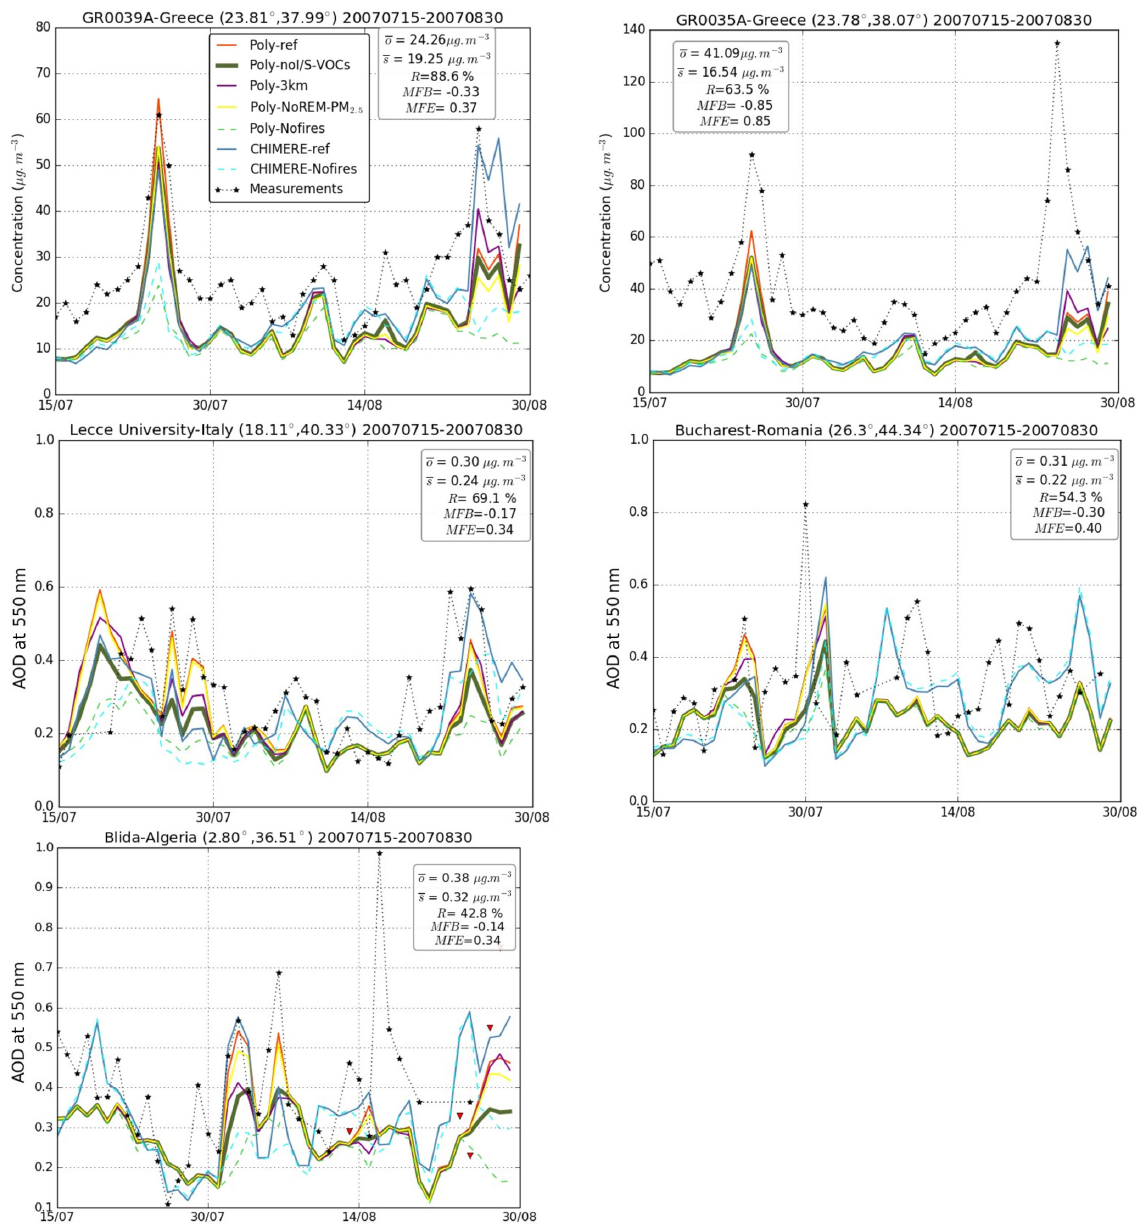
Figure 7. Time series from 15 July to 30 August of daily mean surface PM 2 . 5 concentrations at AIRBASE station GR0039A and GR0035A daily mean AOD at 550nm at three AERONET stations (Lecce University, Bucharest, Blida). The red triangles in Blida station correspond to AERONET measurements using AOD level 1.5 AOD data at 500nm. Statistics for simulation Poly-ref are shown at each